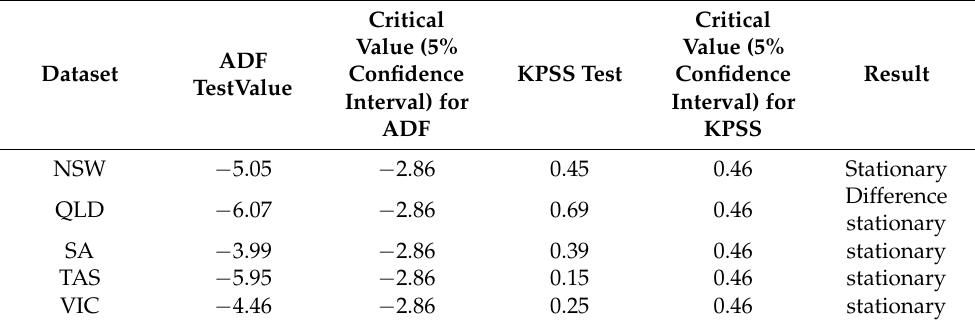
Table 5. The result of ADF test and KPSS test for electrical load prediction of five regions of Australia.